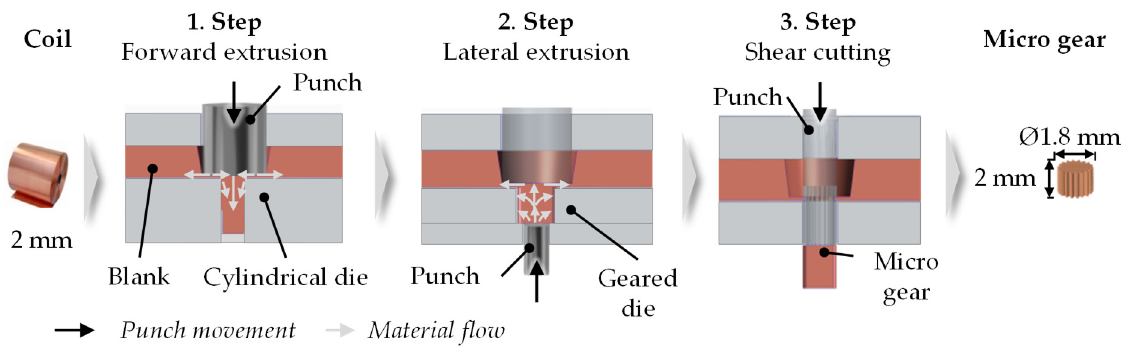
Figure 1. Multi-step forming process for microgear production.